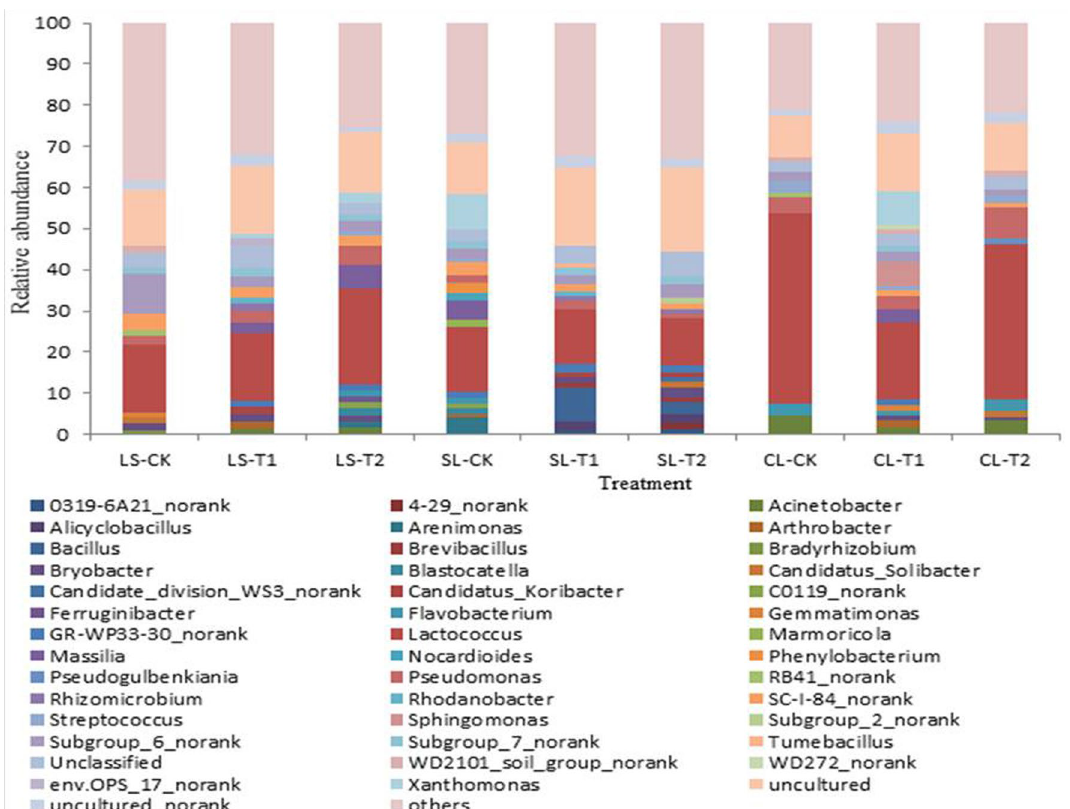
Figure 5. Relative abundance of the bacterial predominant genus for different samples.